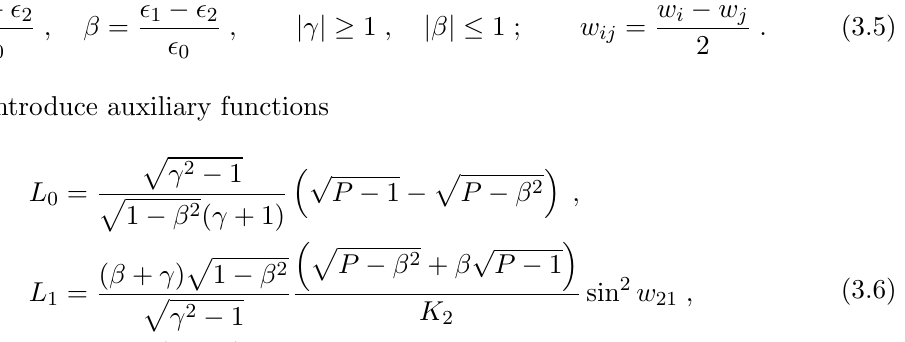
Figure 5 . (a) Two types of N = 2 holographic Steiner trees. (b) A hyperbolic isosceles